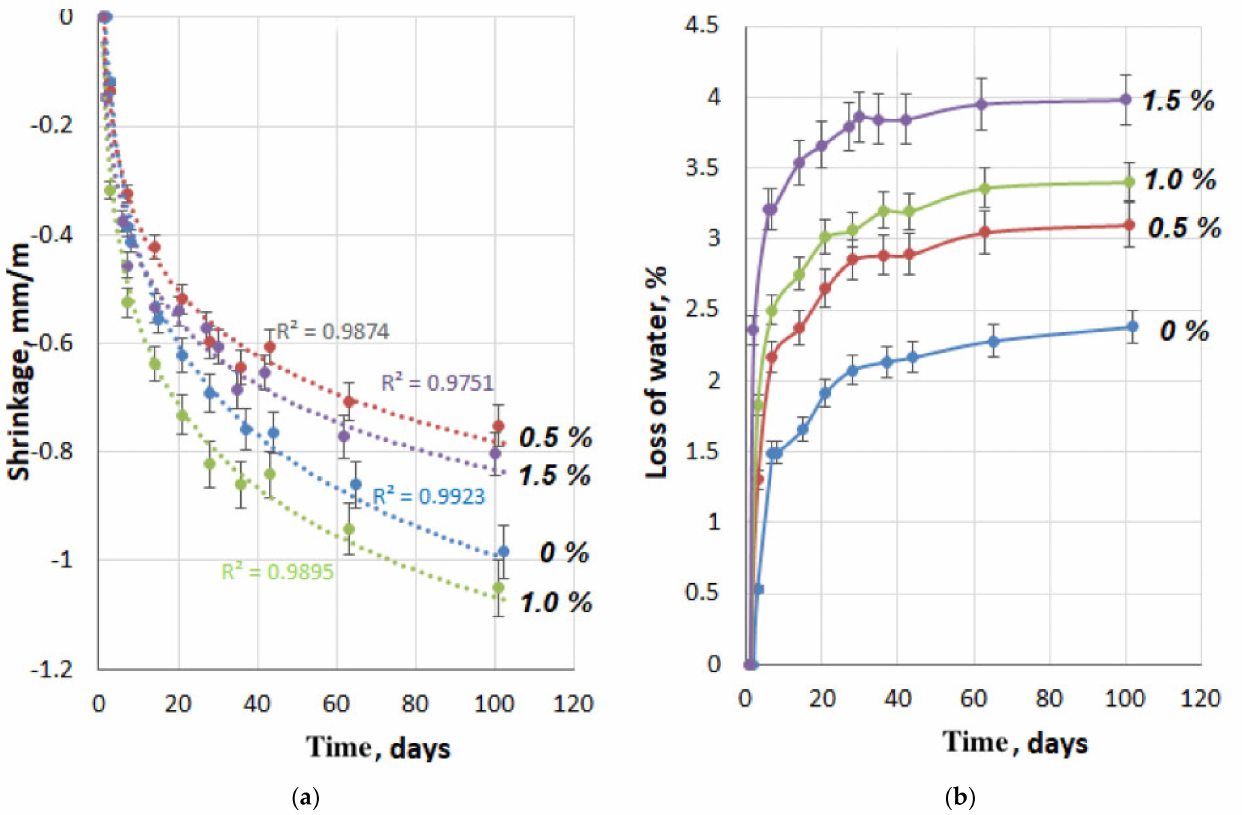
Figure 12. Influence of Pro-Flowstab additive: ( a ) on-air shrinkage deformation; ( b ) water loss for series B